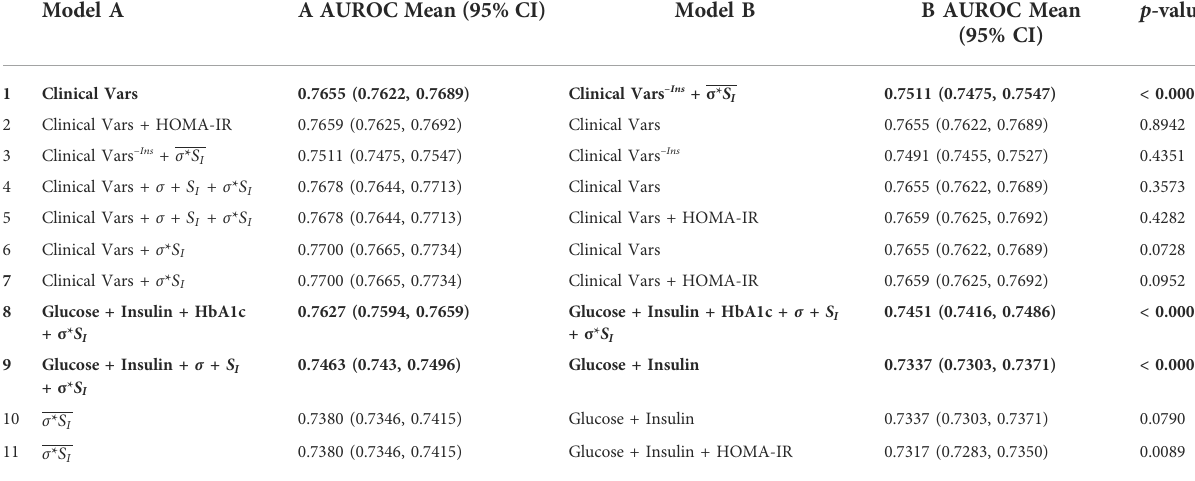
TABLE 5 AUROC comparisons between models trained on subsets of features with and without data assimilation. Models are presented in alphabetical order with the better performing model on the left (Model A). Clinical Vars refers to all clinical features in Tables 2, 3 except pre- operativeIGMstatusandHOMA-IR.ClinicalVars – Ins referstothesamesetoffeaturesinClinicalVarsafterremovinginsulinmeasurements.Overlined parameters were estimated without insulin values. Signi fi cant p -values for two-tailed Student ’ s t -test after Bonferroni correction are shown in bold ( p < 0.004).